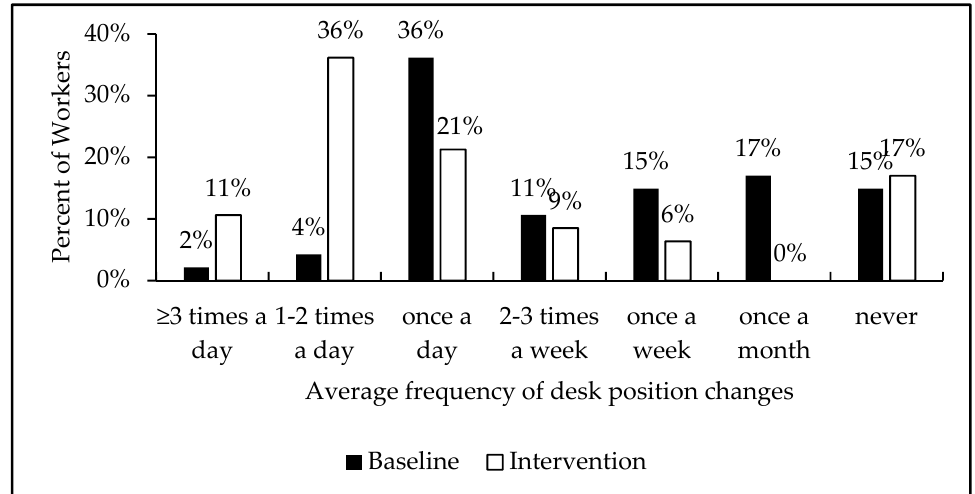
Figure 3. Frequency of desk position changes among workers. The average frequency of desk position changes as a percent of staff members from baseline to intervention are represented here.